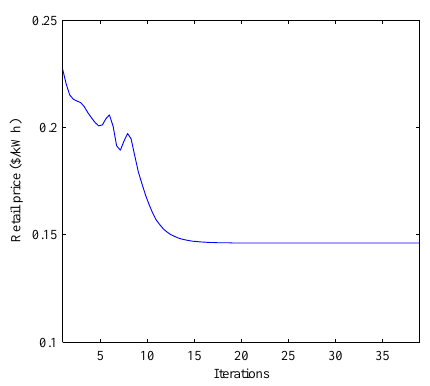
Figure 13. The convergence of the retail price.